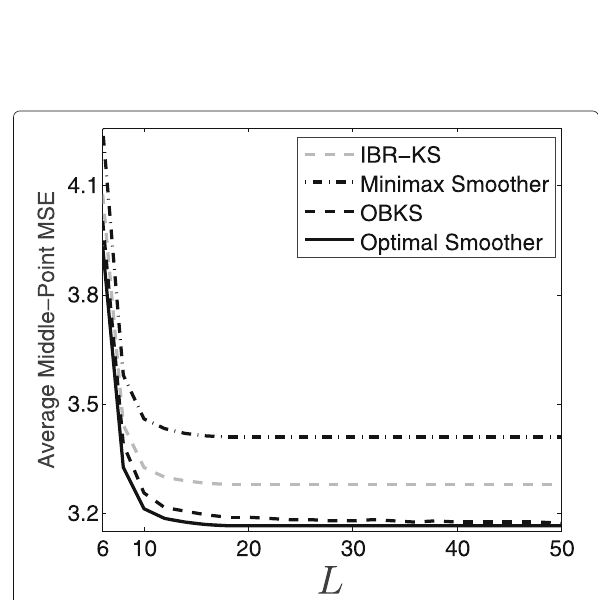
Fig. 4 Average middle-point MSE of different Kalman smoothers for different observation window length